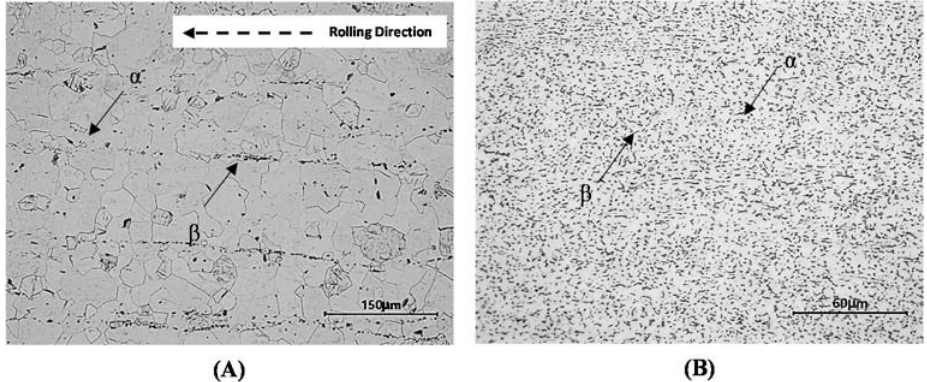
Figure 2. Base metal (BM) microstructures for ( A ) CP-Ti and ( B ) Ti-64. It should be noted that the lower magnification image is shown for CP-Ti to accommodate large grains.